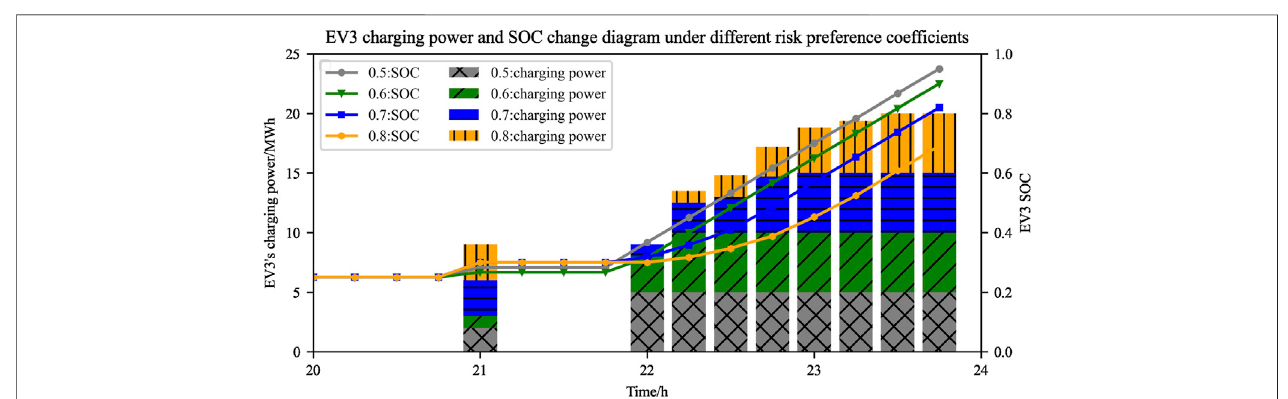
FIGURE 10 | EV3 charging power and SOC change diagram under different risk preference coef fi